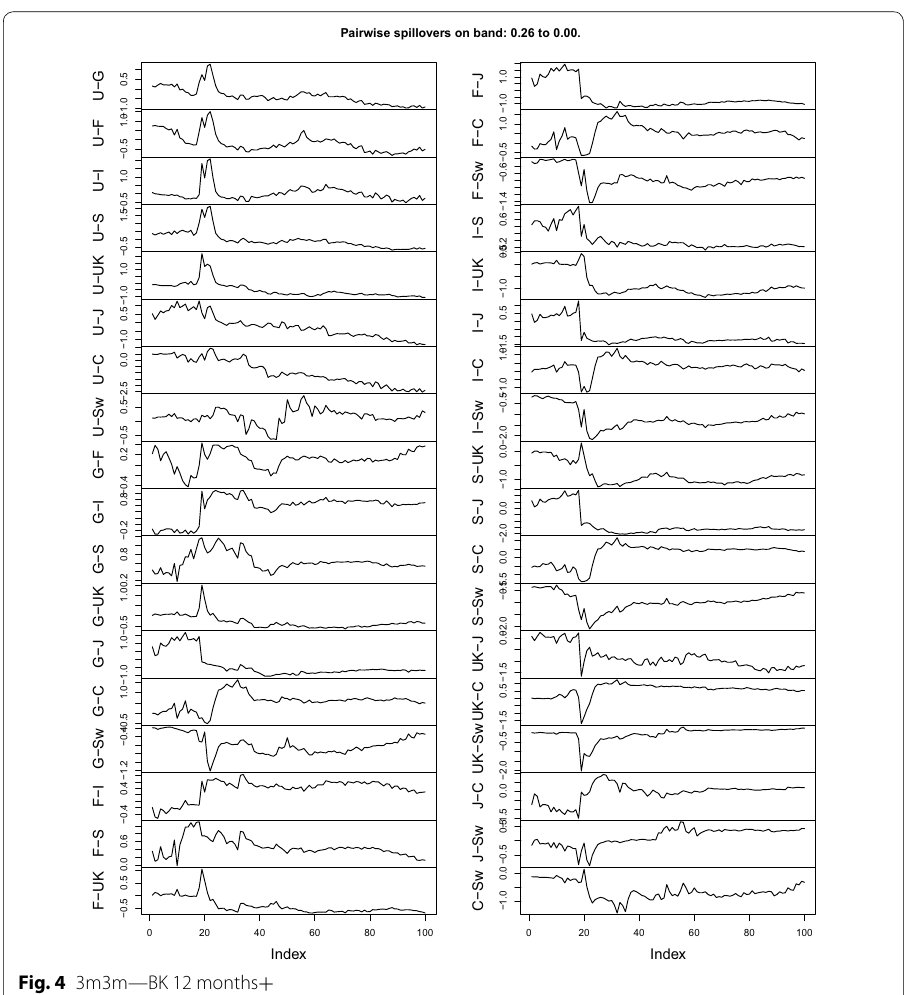
Fig. 4 3m3m—BK 12 months